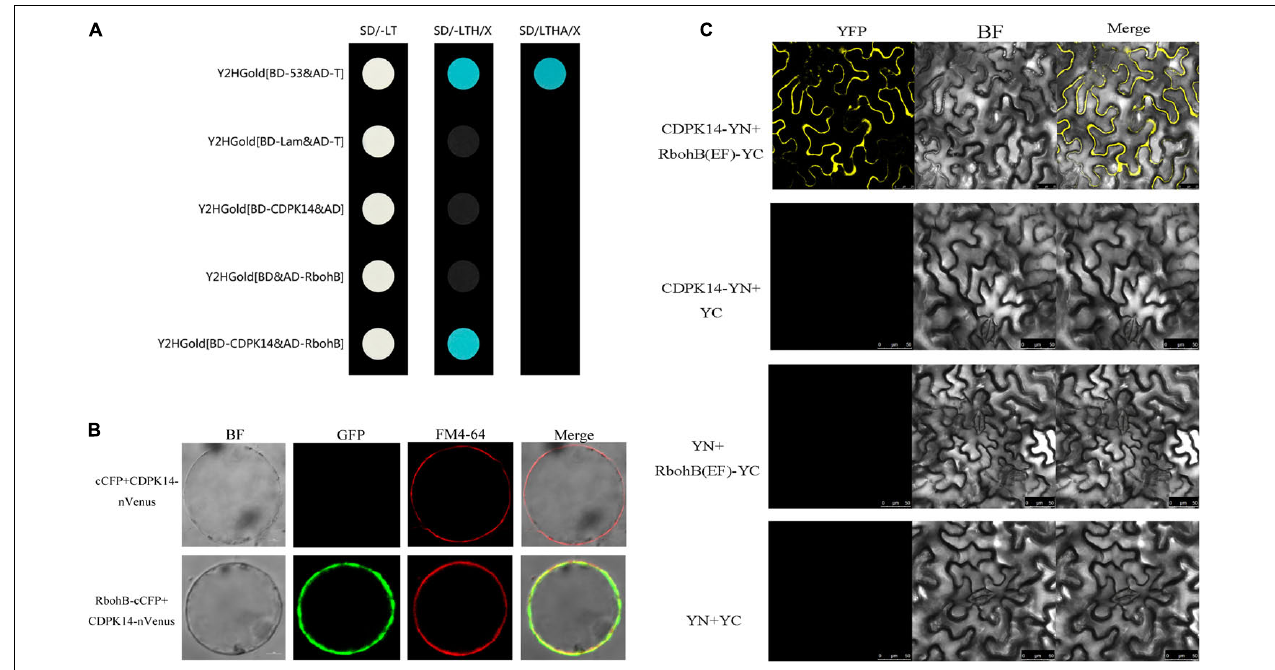
FIGURE 9 | Yeast-two-hybrid assay and a bimolecular fluorescent complimentary (BiFC) assay of interactions between StCDPK14 and StRbohB. (A) Yeast-two-hybrid assay of interactions between StCDPK14 and StRbohB. The pGBKT7-53 + pGADT7-T was set as a positive control and pGBKT7-Lam + pGADT7-T, pGBKT7-StCDPK14 + pGADT7, and pGADT7-StRbohB + pGBKT7 were set as negative control, respectively. (B) A BiFC assay of interactions between StCDPK14 and StRbohB. Full-length StCDPK14 protein was fused to N-terminal Venus (nVenus-CDPK14), and full-length StRbohB was fused to C-terminal CFP (StRbohB-cCFP). The expression of cCFP/nVenus-CDPK14 was used as control. Bar = 10 µ m. (C) A BiFC assay shows interactions between StCDPK14 and the EF-hand motifs of StRbohB in tobacco leaf epidermal cells. StCDPK14 and the EF-hand motifs of StRbohB were fused with the N and C termini of YPF. StCDPK14 with C-terminal alone, StRbohB (EF) with N-terminal alone and only C, N-terminal was used as the negative control. Bar = 20 µ